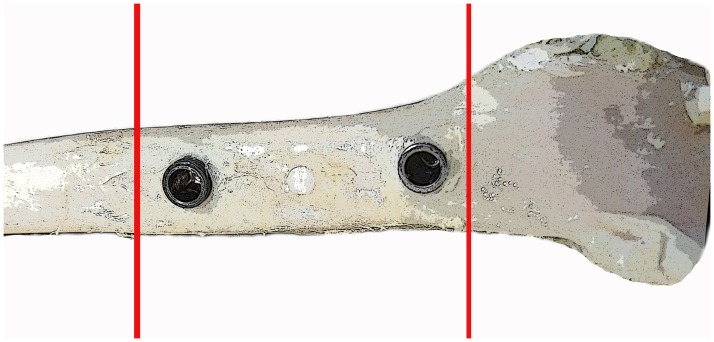
Representative image of the position predeterminate to install the implants (between the red lines), avoiding the most proximal position where bone tissue is less dense.